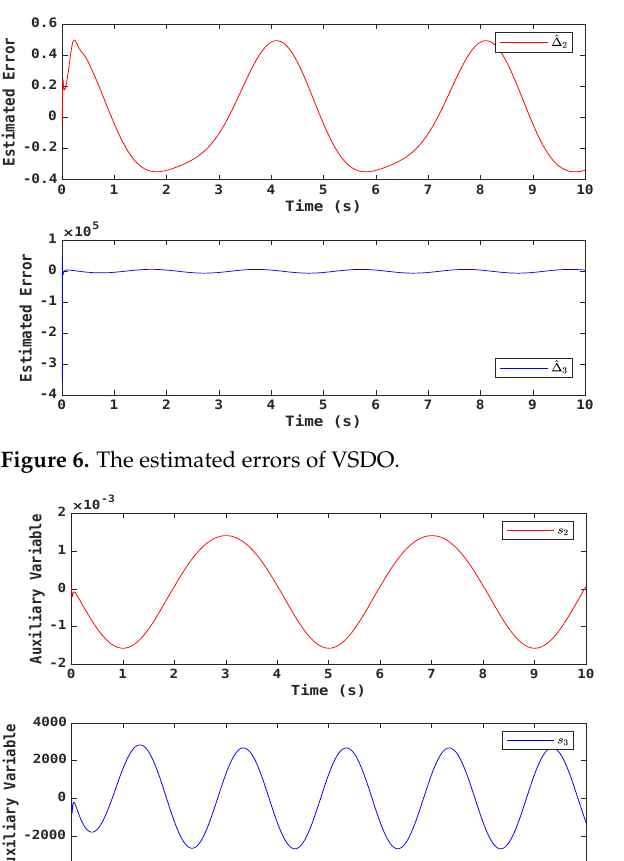
Figure 5. The estimated values of VSDO.